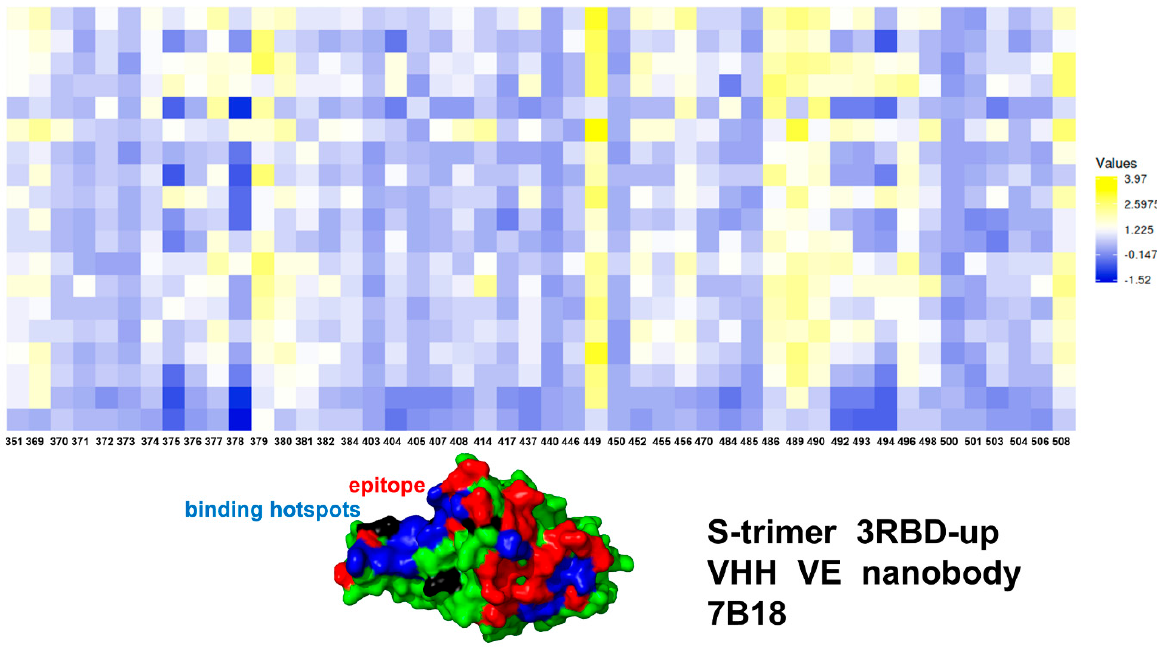
Figure 6. The mutational scanning heatmap for the SARS-CoV-2 S trimer complex with VHH VE nanobody, pdb id 7B18. The binding energy hotspots correspond to residues with high mutational sensitivity. The heatmaps show the computed binding free energy changes for all single mutations on the binding epitope sites. The squares on the heatmap are colored using a 3-colored scale—from blue to yellow, with yellow indicating the largest destabilization effect. Structural map of the bind- ing epitopes and binding energy hotspots for VHH VE. The S-RBD is shown in green surface. The epitope residues are in red, and the binding energy hotspots are shown in blue surface. The com- puted standard errors of the mean for the binding free energy changes are based on selected samples from atomistic trajectory reconstructed from CG-CABS simulations (1000 samples) and are within 0.15–0.23 kcal/mol. Consistent with our earlier studies [105], mutational scanning and energetic cartog- raphy analysis suggested that VHH E/VHH V can use binding of VHH V at the cryptic binding site to form a structurally stable anchoring platform that allows for modulation of functional movements of VHH E and provides allosteric control over structural changes in the RBM epitope. Due to synergistic avidity effects, binding of the VHH E arm at the RBM epitope may then lower the entropic penalty and allow for local structural accom- modations to compensate for the loss of binding interactions. This may underlie a mech- anism by which multivalent nanobodies can leverage long-range couplings to synergisti- cally inhibit distinct binding epitopes and suppress mutational escape. We also examined the effect of Omicron mutations in the RBD (G339D, S371L, S373P, S375F, K417N, N440K, G446S, S477N, T478K, E484A, Q493R, G496S, Q498R, N501Y, Y505H) on binding of Nb6, VHH E, and VHH E/VHH V nanobodies (Figure 7). Im- portantly, some of the Omicron mutations could significantly affect Nb6 binding, partic-